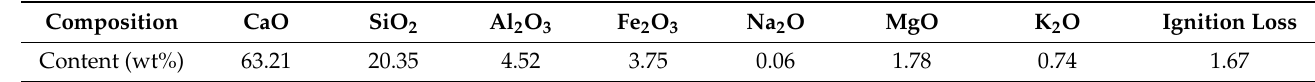
Table 1. Chemical composition of Portland cement.